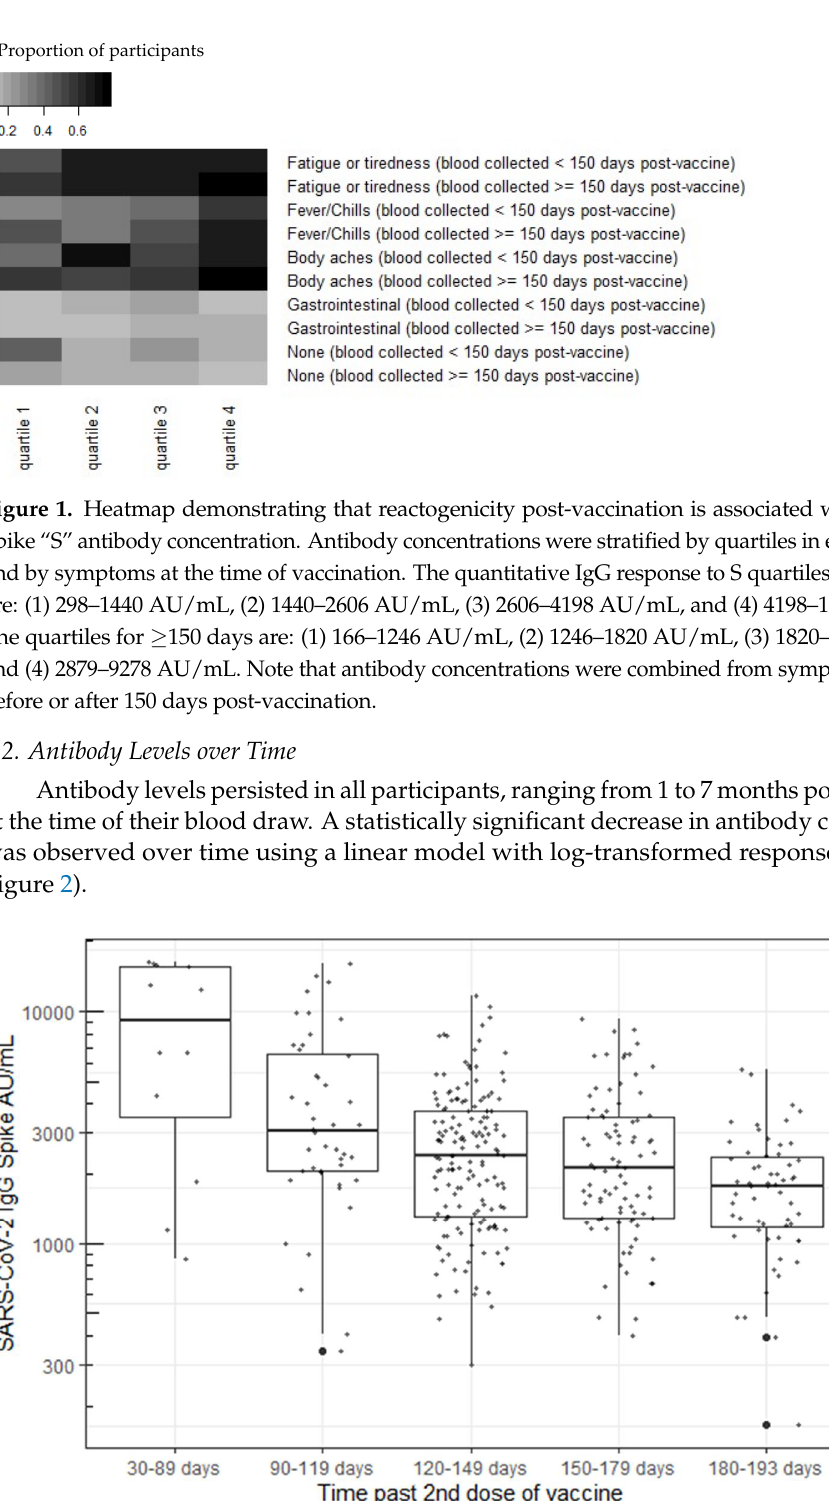
Figure 2. B. Decrease in Spike “S” IgG antibody concentration over time using the Abbott’s Ad- viseDx SARS-CoV-2 IgII assay.